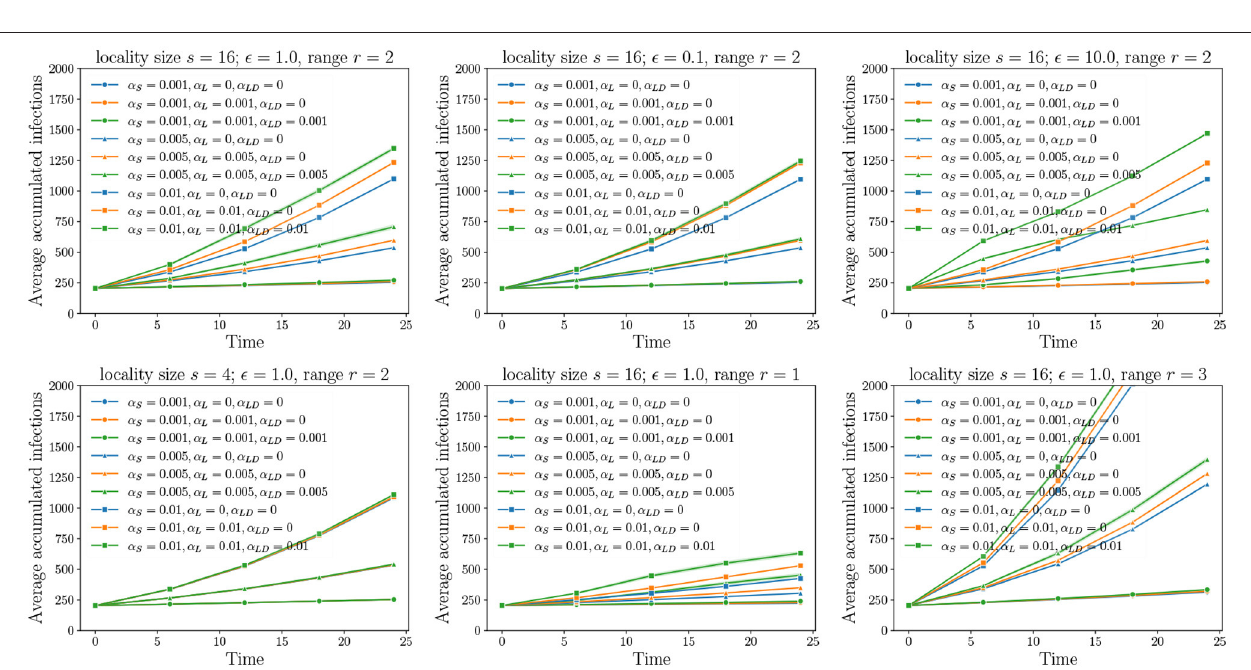
FIGURE 5 | Unraveling pathways: Here, we choose a positive value 0 incrementally unravel the pathways starting the edges from the grid ( α s inter-locality edges ( α s replicates of the